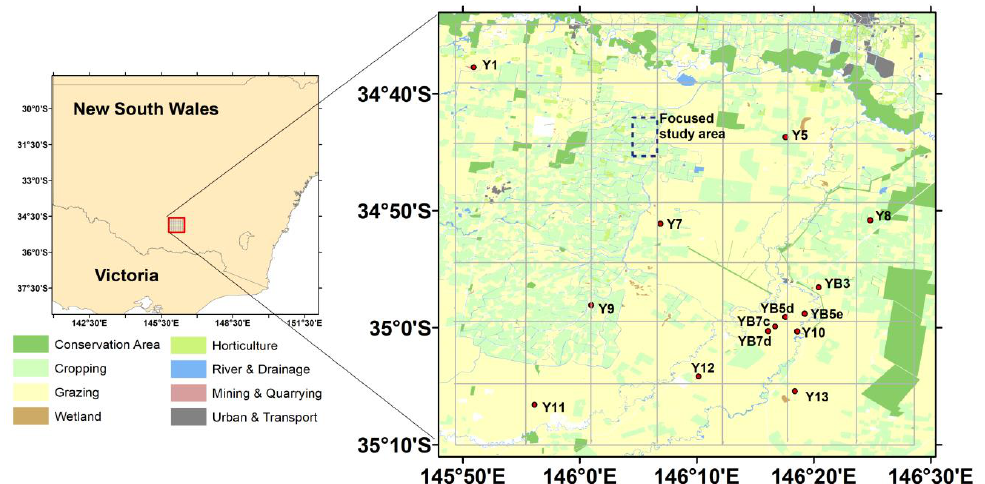
Figure 1. Location of the study region (red rectangle) consisting of 7 by 7 SMAP 9-km grid cells (gray lines) used for preparing spatially and temporally matched data sets for machine learning, Yanco soil moisture network (stations marked by red circles with names labeled) used for assessing the accuracy of downscaled SSM, and a focused study area (dark blue dash lines) with intensive soil moisture sampling for examining local-scale SSM distribution patterns.